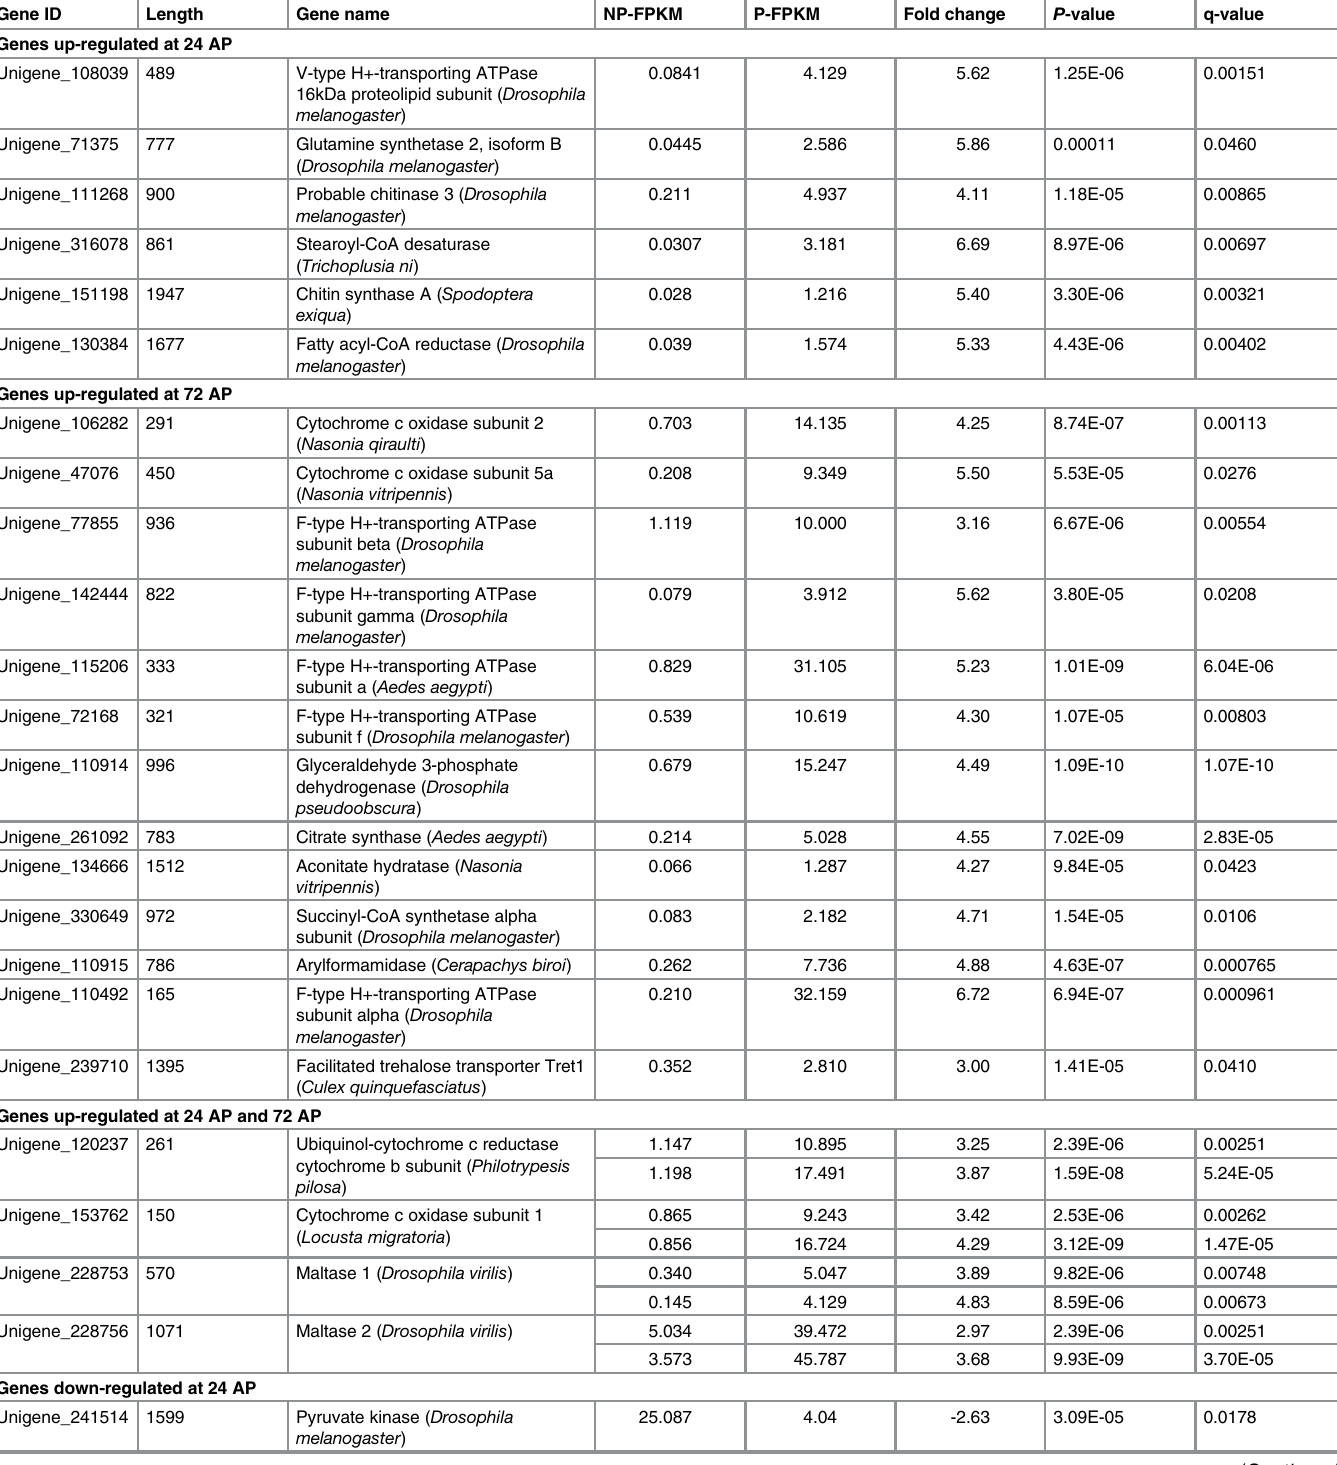
Table 3. Metabolism-related genes differentially expressed in B . tabaci after being parasitized by E . sophia . Gene